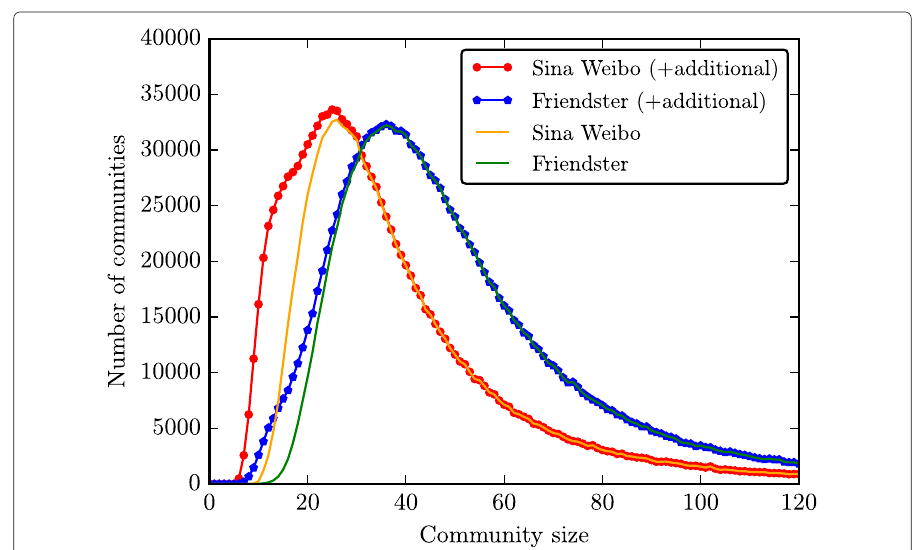
Fig. 8 Size distributions of the communities detected in the two social networks